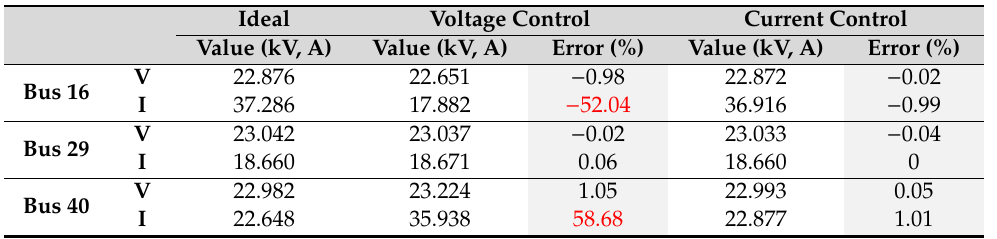
Table 2. Voltage and current errors of DGs corresponding to control targets with 1% of measurement errors in buses 16 and 40. Ideal Voltage Control Current Control